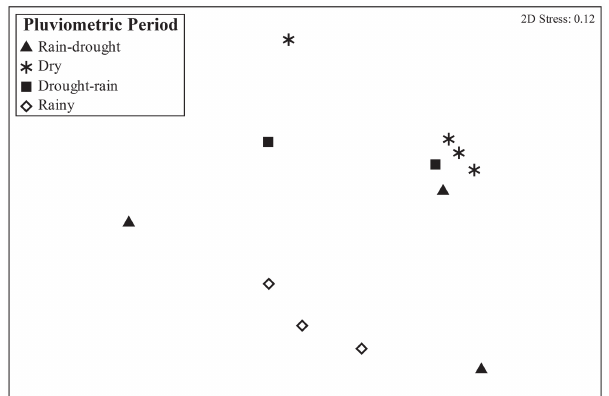
Fig. 3. Non-metric Multidimensional Scaling based on the Alimentary Index (AI %) of all food items consumed by the i rock-bacu Lithodoras dorsalis among pluviometric periods, rio Amazonas mouth region, Brazil.